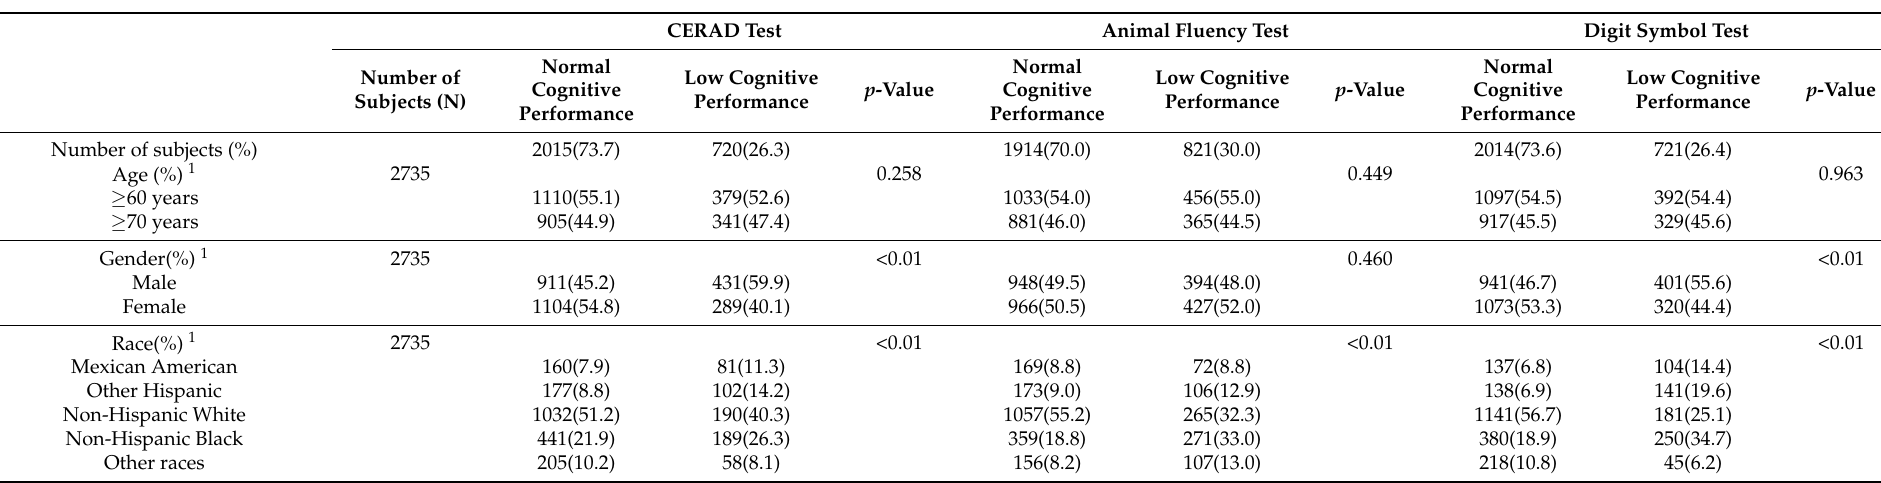
Table 3. Characteristics of the serum 25(OH)D and cognition study population, National Health and Nutrition Examination Survey (NHANES) 2011–2014 (N =